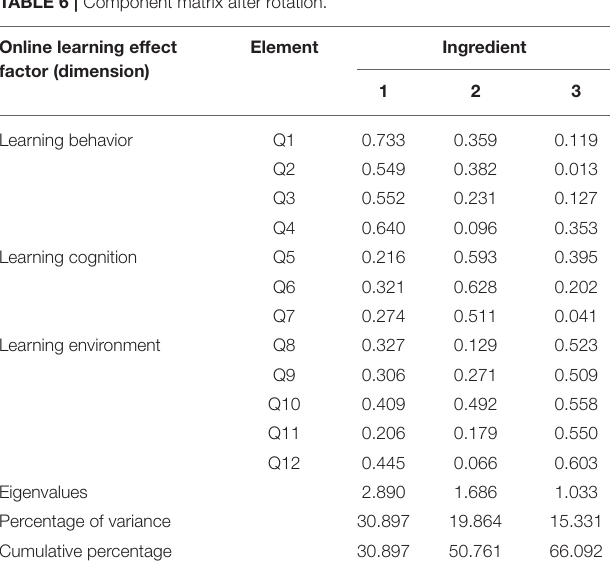
TABLE 6 | Component matrix after